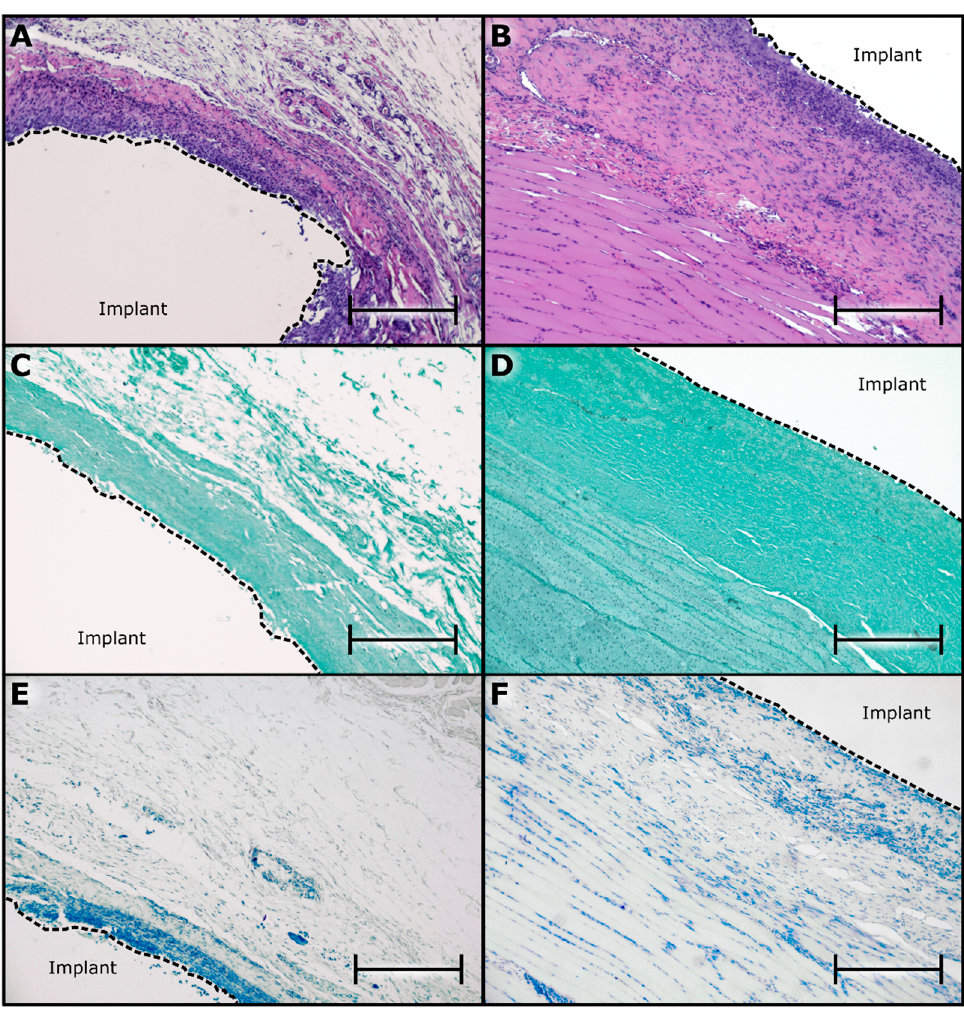
Figure 4. Histological inflammatory response to nTAF t . ( A ) Representative H&E stain of NHP skin surrounding nTAF t in contact with the titanium reservoir. ( B ) Representative H&E stain of NHP skin surrounding nTAF t near the TAF-releasing nanofluidic membrane. ( C) Grocott methenamine silver stain of NHP skin surrounding nTAF t in contact with the titanium reservoir. ( D ) Grocott methenamine silver stain of NHP skin surrounding nTAF t near the TAF-releasing nanofluidic membrane. ( E ) Acid-fast bacteria stain of NHP skin surrounding nTAF t in contact with the titanium reservoir. ( F ) Acid-fast bacteria stain of NHP skin surrounding nTAF t near the TAF-releasing nanofluidic membrane. All images taken at 10 × magnification with 400 µm scale bar.